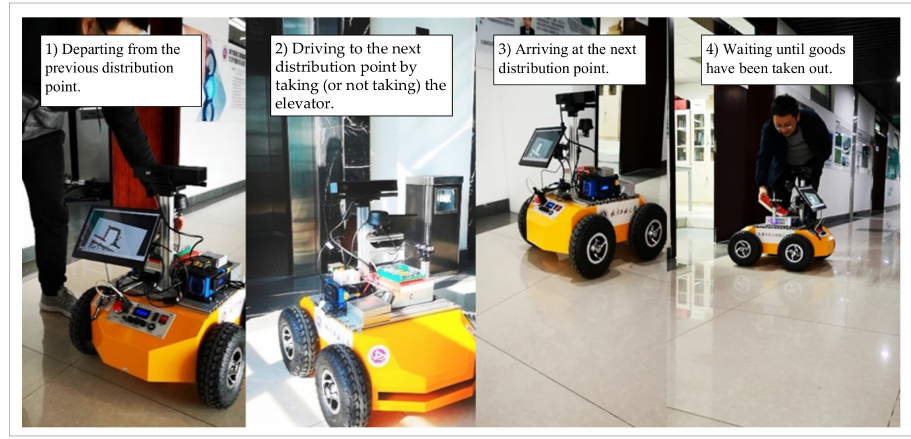
Figure 11. The distribution process of the experiment.